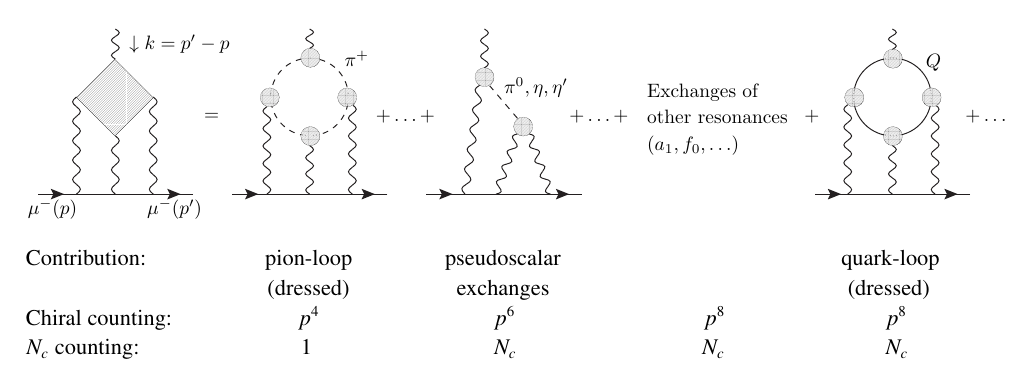
Figure 1. The di ff erent contributions to HLbL scattering in the muon g − 2 and their chiral and large- N c counting.